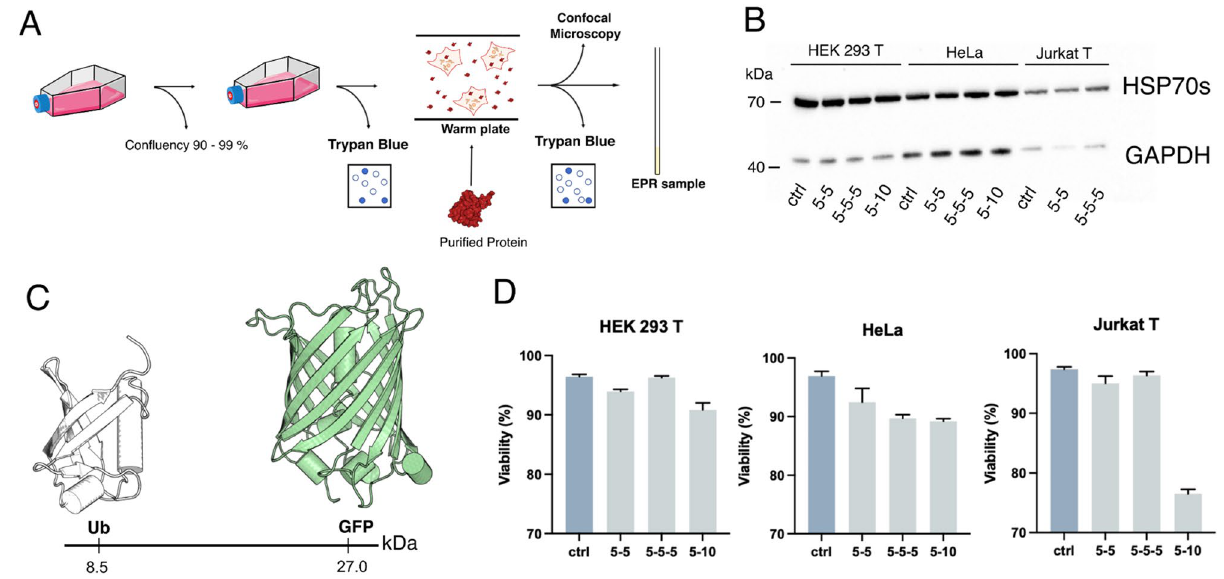
Figure 1. ( A ) Schematic representation of the developed thermal stimulation delivery method (HS). ( B ) HSP70s WB assay conducted on the HEK 293 T, HeLa and Jurkat T cells after the thermal stimulation delivery. ( C ) PDB structures of the proteins used in this work (Ub: 1UBQ.pdb GFP: 1GFL.pdb). ( D ) Trypan blue Viability assay for control and treated cells with the three tested thermal stimulation schemes in absence of external protein. The raw western blot membrane is shown if the Supplementary Information, Fig.